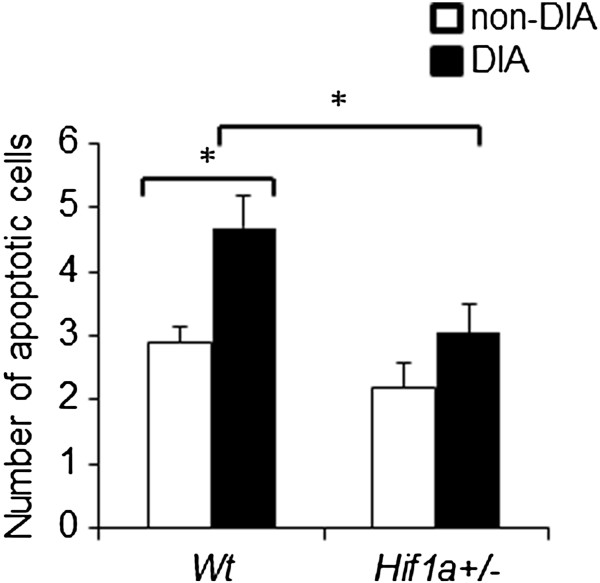
Apoptosis in the diabetic and non-diabetic hearts of Wt and Hif1a+/-mice. The apoptotic cells were detected with TUNEL assay. The apoptotic cells were counted in the whole heart, including the myocardium of left and right ventricles, and the atrioventricular septum. The values represent mean ± SEM (n = 3 individuals × 3 heart sections per group); *P < 0.05, (2-way ANOVA with Tukey’s post-test).